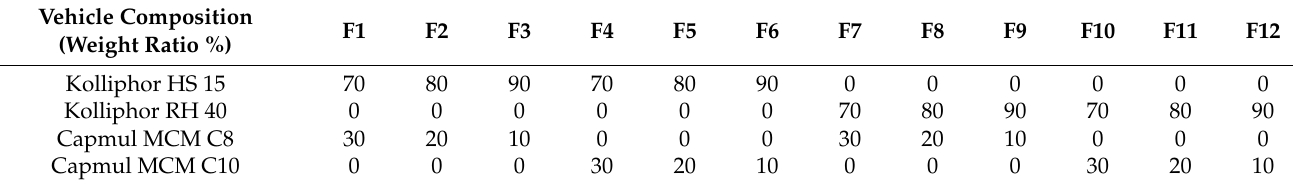
Table 2. Vehicle compositions for ALH-Loaded SNEDDS and Su-SNEDDS.